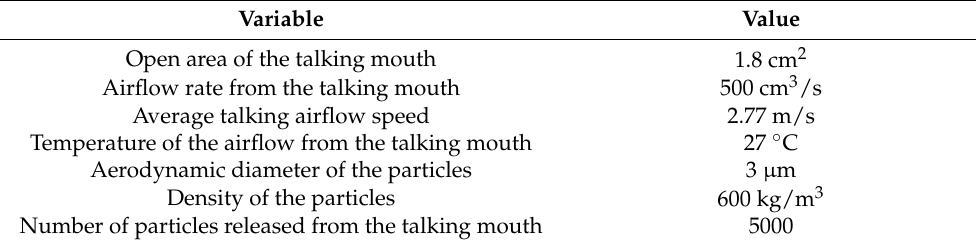
Table 2. Particle release conditions [16,20].